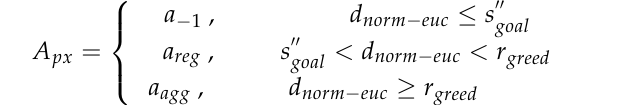
Figure 11. Method for estimating the action set associated with proximity metric.